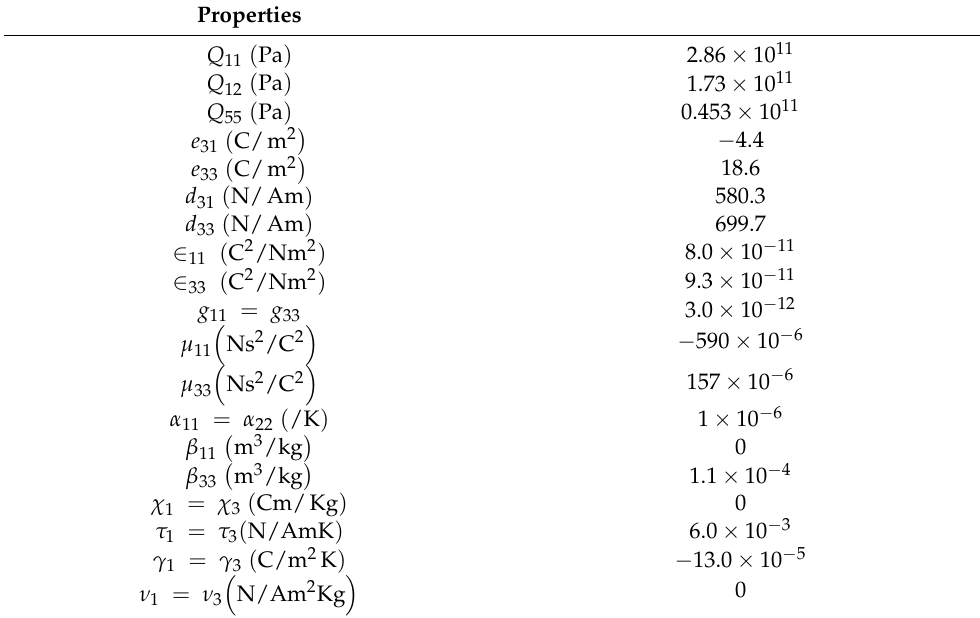
Table 1. Material properties of BaTiO 3 /CoFeO 4 [33].